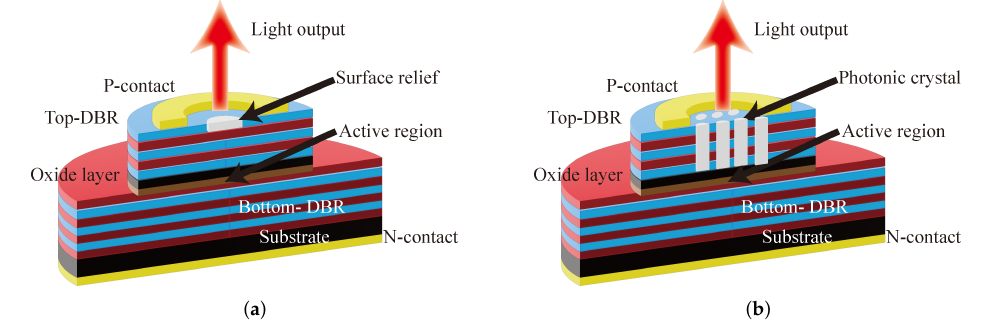
Figure 5. Different structures to realize single-mode outputs ( a ) surface relief VCSEL; ( b ) photonic crystal